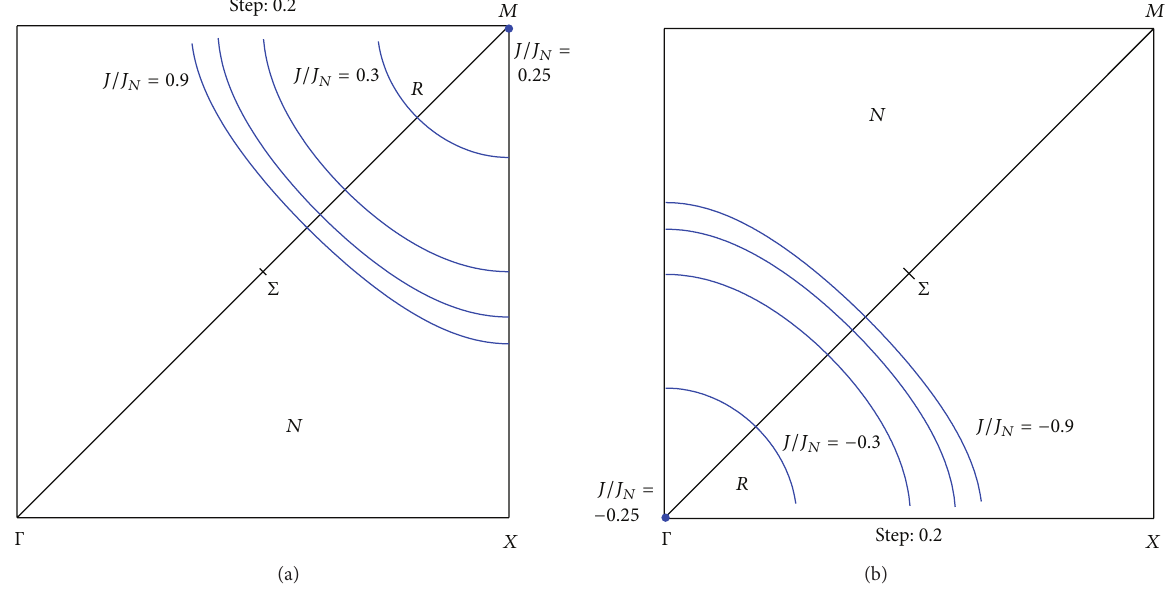
Figure 5: Two regions in the SBZ for sc(001) surface cut, with normal ( 𝑁 ) and reverse ( 𝑅 ) mode order in the spin-wave spectrum, for (a) ferromagnetic and (b) antiferromagnetic NNN interactions. The boundary between the regions shifts with growing |𝐽 𝑁 |/𝐽 towards the SBZ center as shown by blue curves. For the critical value |𝐽 𝑁 |/𝐽 = 0.25 the reversal domain does not occur (its boundary amounts to points 𝑀 and Γ in (a) and (b), resp.).